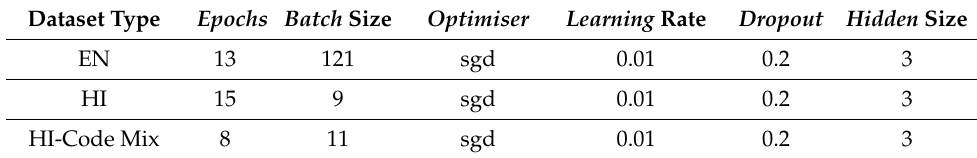
Table 8. Parameter optimisation for BERT model. Dataset